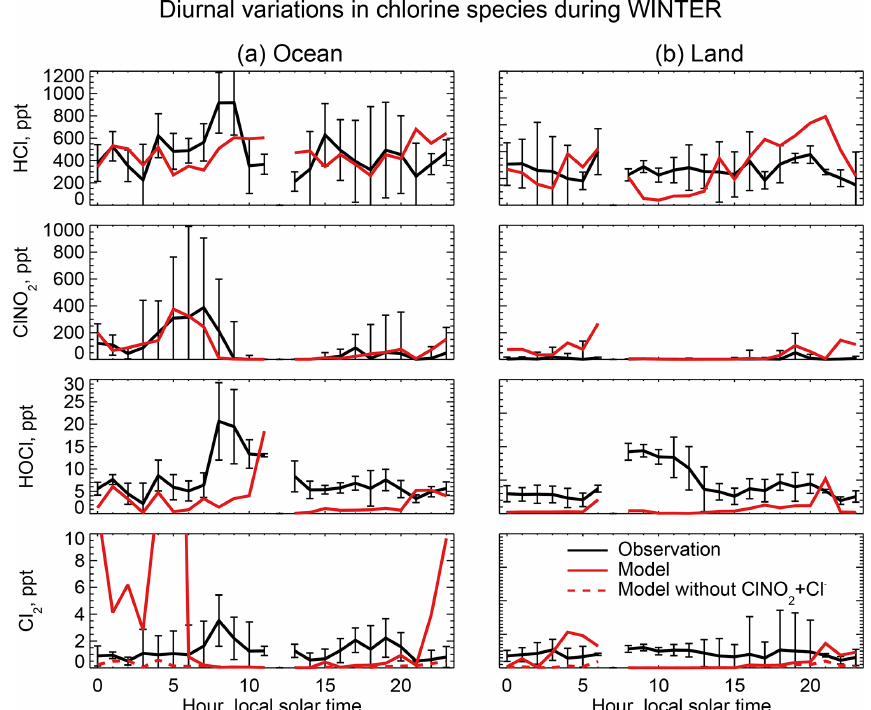
Figure 7. Median diurnal variations in HCl, ClNO 2 , and Cl 2 mixing ratios below 1km in altitude during the WINTER aircraft campaign over the eastern US and offshore in February–March 2015. The data are separated between ocean (a) and land (b) . Model values are compared to observations from Haskins et al. (2018). Vertical bars show the 25th–75th percentiles in the observations. Measurements below the detection limit are treated as the median of 0 and detection limit. Also shown are results from a sensitivity simulation excluding ClNO 2 + Cl − , which has a negligible effect on HCl, ClNO 2 , and HOCl but brings the Cl 2 simulation in much better agreement with observations at